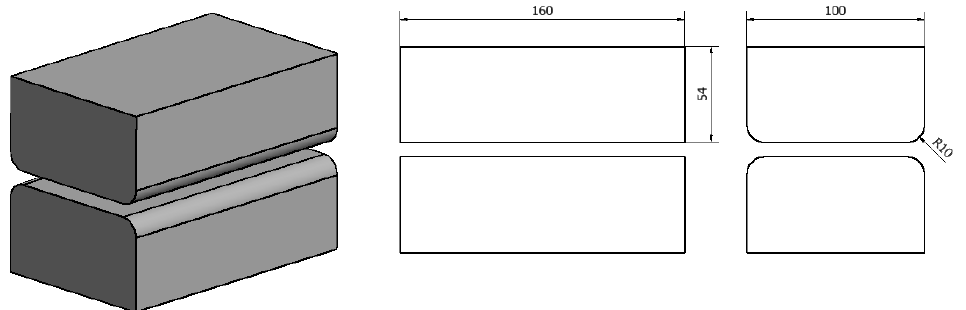
Figure 3. Shape and dimensions of flat dies used for AZ91 magnesium alloy forging [15].